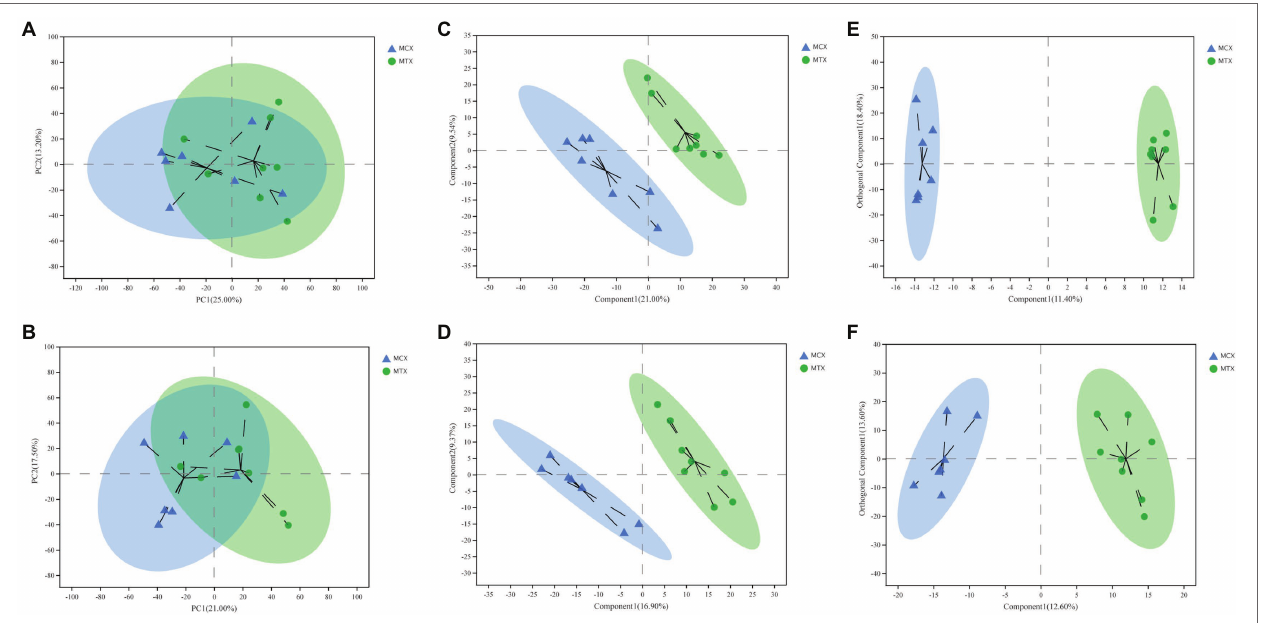
FIGURE 2 | Multivariate statistical analysis of Cd concentrations in the digestive tissues of O. oratoria . Principal component analysis (PCA) score chart in positive (A) and negative (B) modes. Partial least squares discriminant analysis score chart in positive (C) and negative (D) modes. Orthogonal partial least squares discriminant analysis score chart in positive (E) and negative (F) modes.